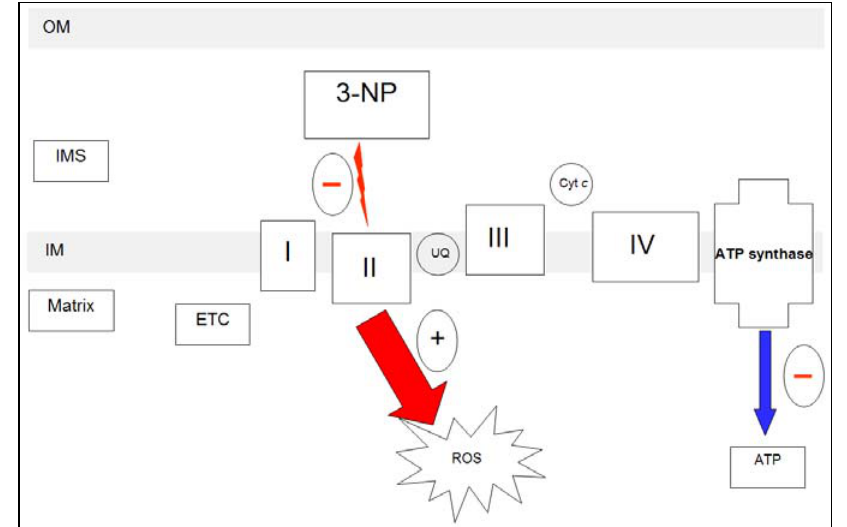
Figure 1. 3-NP irreversibly inhibits succinate dehydrogenase (SDH; complex II) of electron transport chain (ETC) and tricarboxylic acid cycle. Schematic representation of the effect of 3-NP on ETC. IM: inner membrane; IMS: Intermembrane space; OM: outer membrane. Complex I: NADH dehydrogenase; Complex III: Cytochrome bc cytochrome c reductase; Complex IV: Cytochrome c oxidase; Complex V: ATP